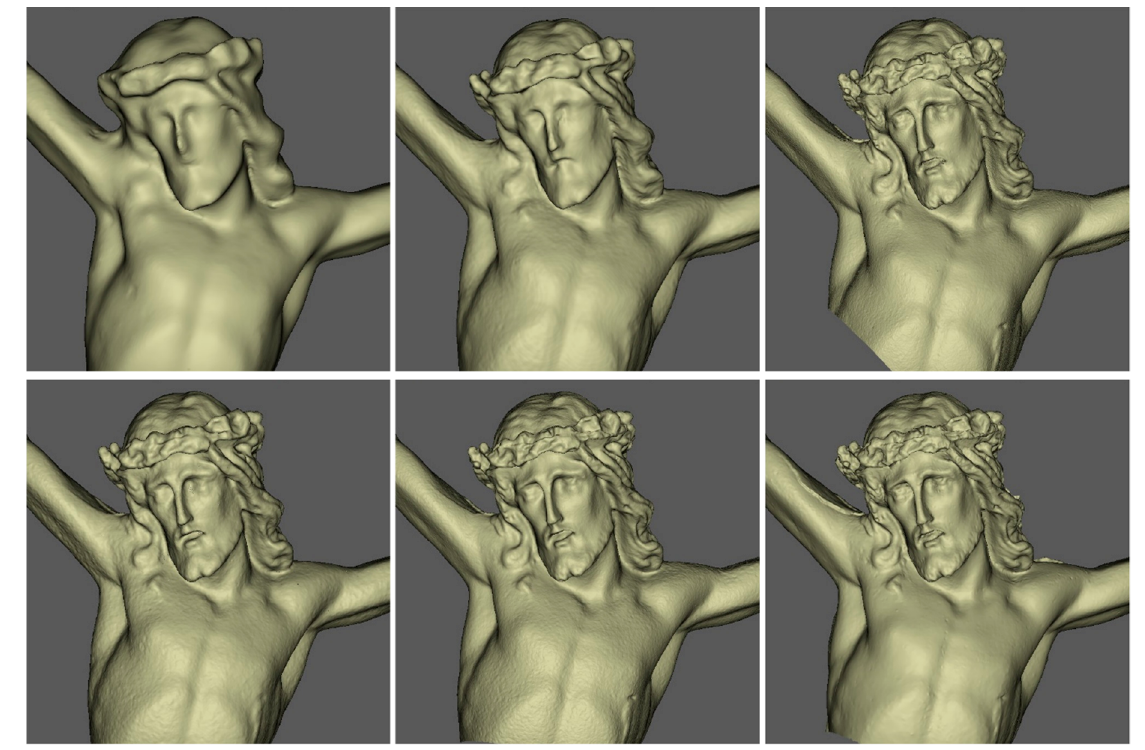
Figure 14. Untextured meshes of the small sculpture, (from left to right, and from top to bottom): F6 SR, AMP–dataset 7, AMP–dataset 8, FZA–dataset 7, FZA–dataset 8, and ARP–dataset 8.